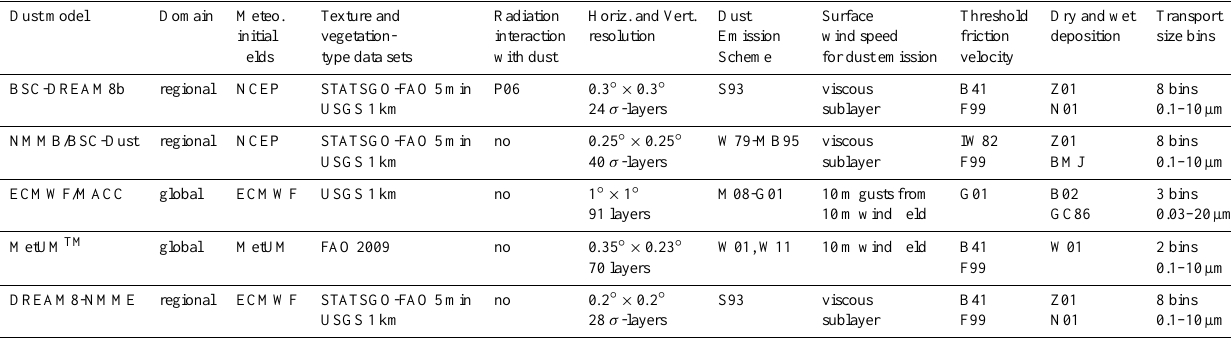
Table 1. Summary of the main features of each model included in the present contribution. Dust